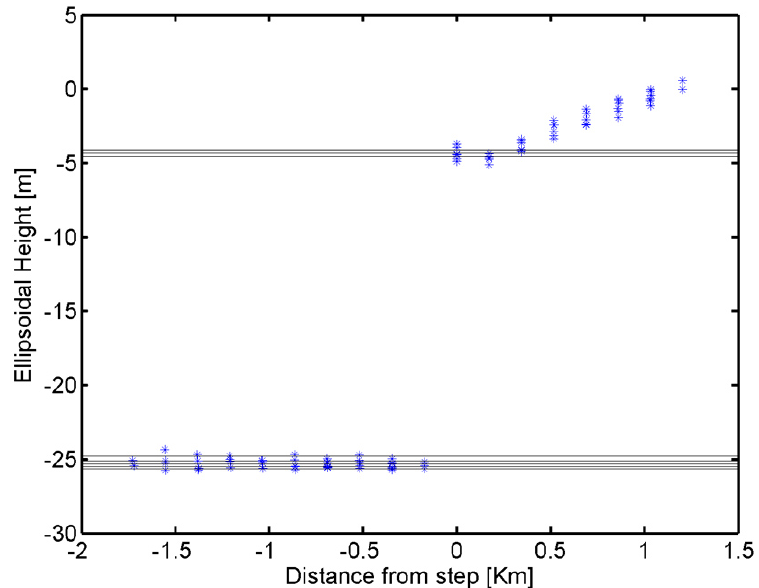
Figure 15. Available ICESat elevation profiles over Zone 2 (seven profiles). Horizontal distance refers to the first point over the ice shelf on each profile. Calculated surface and base heights for each profile are shown as black horizontal